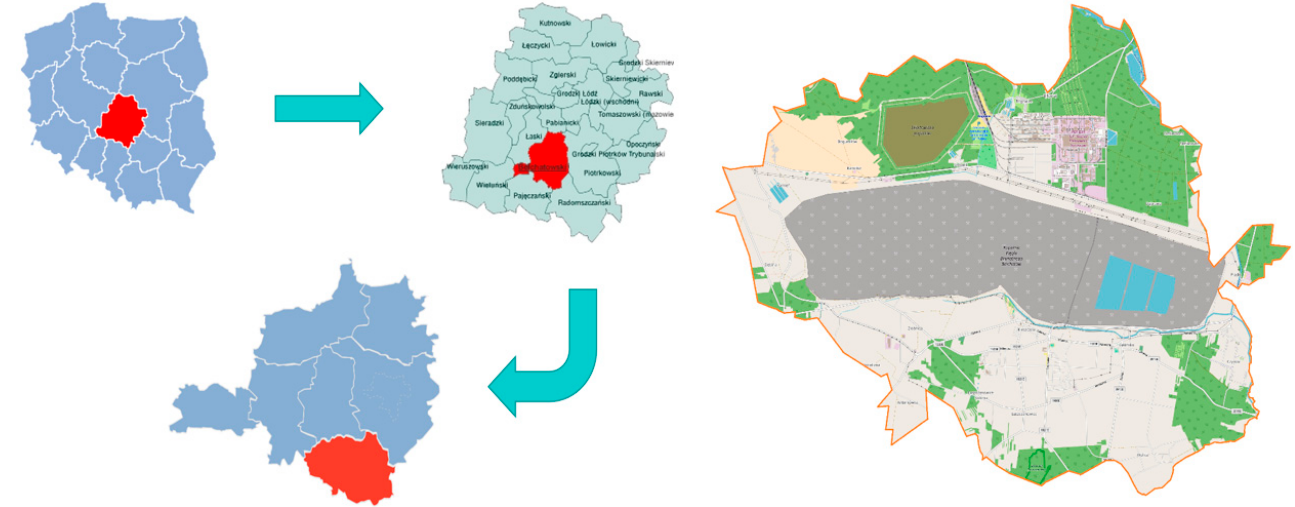
Figure 3. Location of the municipality of Kleszcz ó w in Poland ( left ) and exact location of the open-cast lignite mine in the municipality of Kleszcz ó w ( right ) [Source: own elaboration]. Kleczew, in turn, is an urban-rural municipality in Wielkopolskie Voivodeship (see Figure 2), in Koni ń skie County, with an area of 110 km 2 . In 2017, it had 9991 inhabitants (Central Statistical Office). On its territory, there are currently 38 villages organised into 19 administrative units.